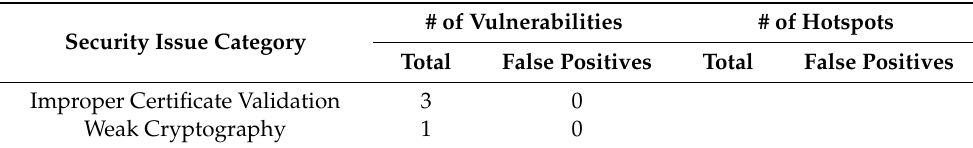
Table 11. Number of security issues of different categories in JavaSMQ.